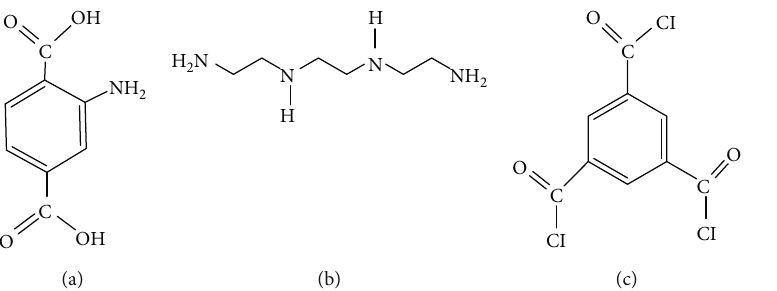
Figure 13: Schemes of (a) 2-amino-terephthalic acid, (b) triethylenetetramine, and (c) 1,3,5-benzenetricarboxylic acid